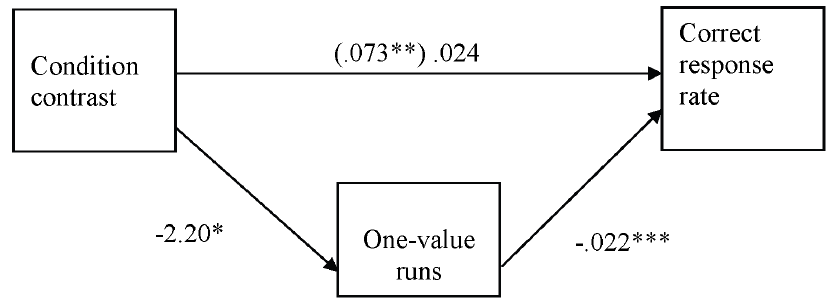
Figure 4. One-value runs as a mediator of the relation between condition contrast and correct response rate (Experiment 2). All coefficients are unstandardized. The coefficient in parenthesis does not control for the effect of one-value runs. **p , .01, ***p ,